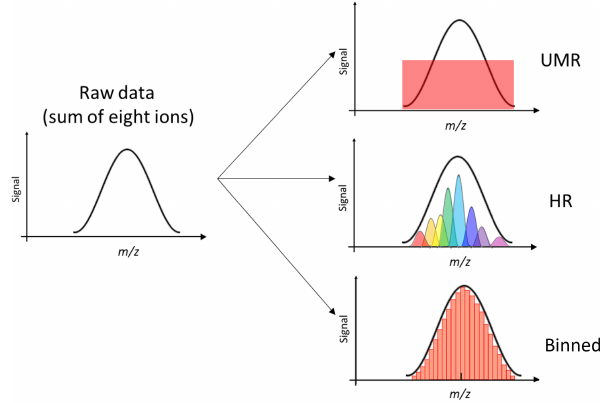
Figure 2. Conceptual comparison of traditional methods (UMR and HR) and binned mass spectra for PMF analysis. The raw data sig- nal is shown in the left and contains eight ions. By UMR analysis, the information of the eight ions is totally lost. Using an analyst- determined peak list, HR analysis attempts to separate signals at this mass by fitting selected ions. By binning the spectra, we utilize the HR information without any a priori information